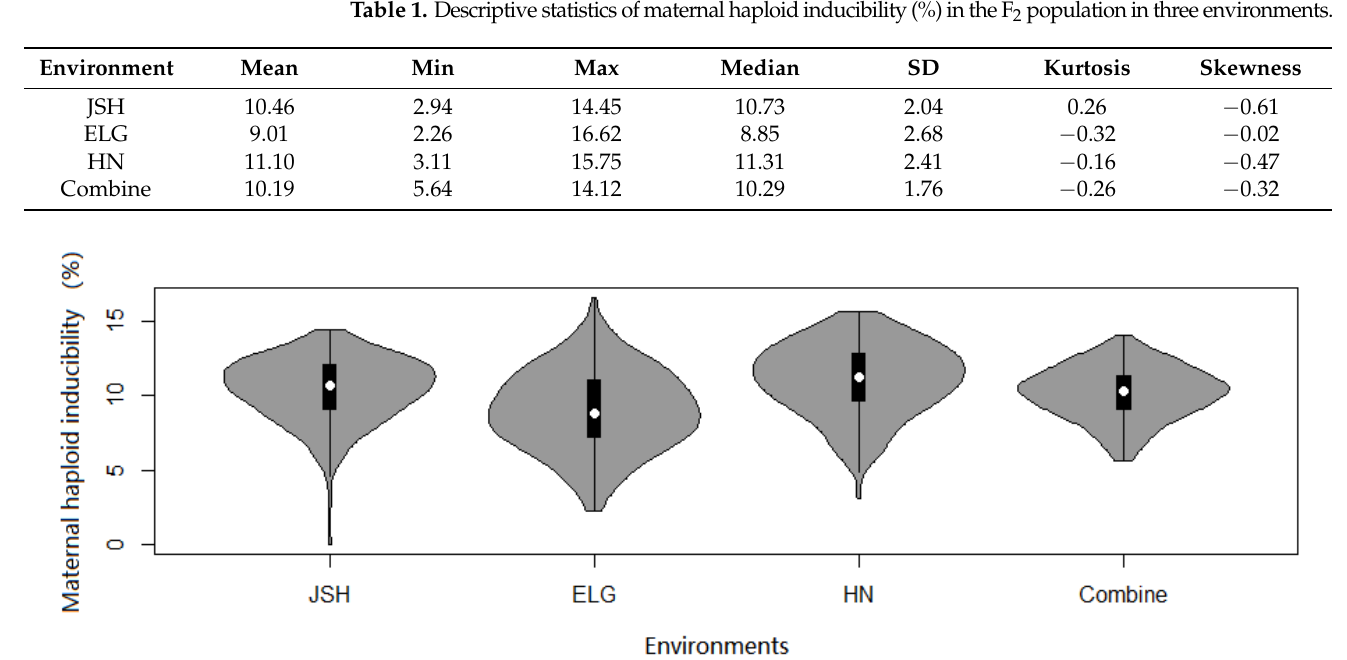
Figure 2. Violin plots of maternal haploid inducibility in the F 2